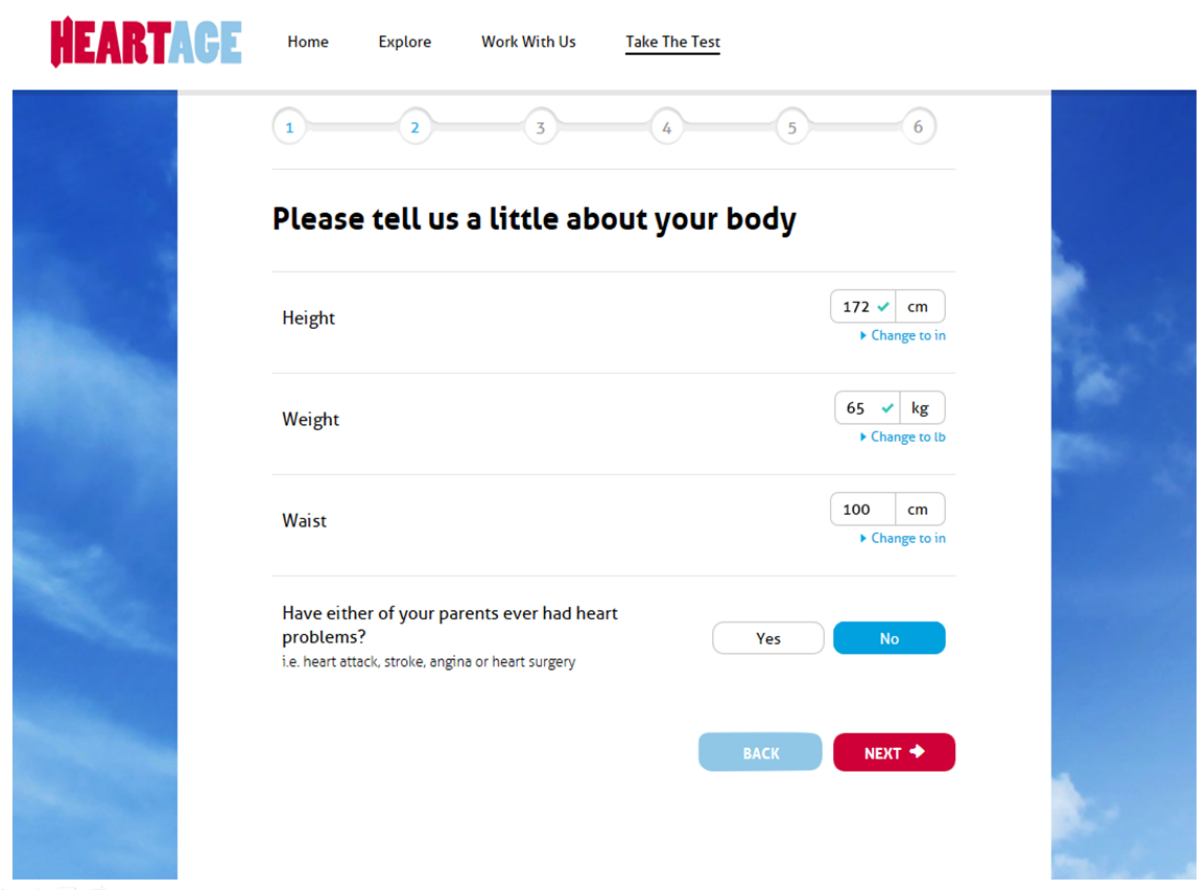
Figure 1. Screenshot of the Heart Age